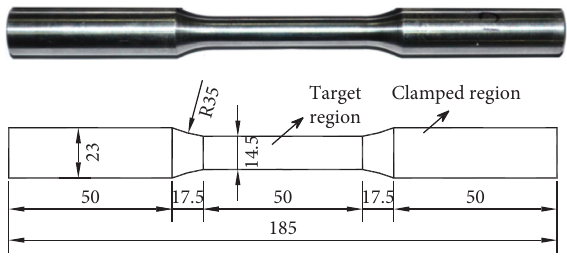
Figure 1: Geometry and dimensions of the material specimen (in mm).